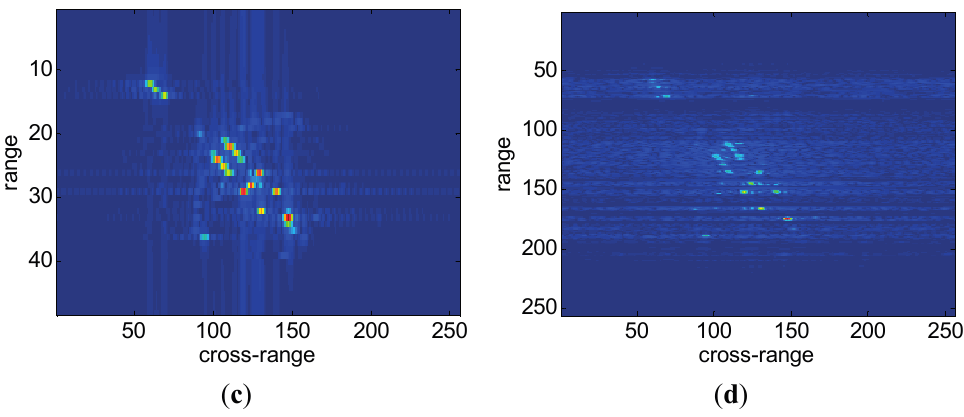
Figure 3. ( a ) Range profiles via IFFT method (64 samples for each echo pulse); ( b ) Range profiles with irregular RCM via SR algorithm (256 grid points); ( c ) ISAR image corresponding to the range profiles in 3a; ( d ) ISAR image corresponding to range profiles in